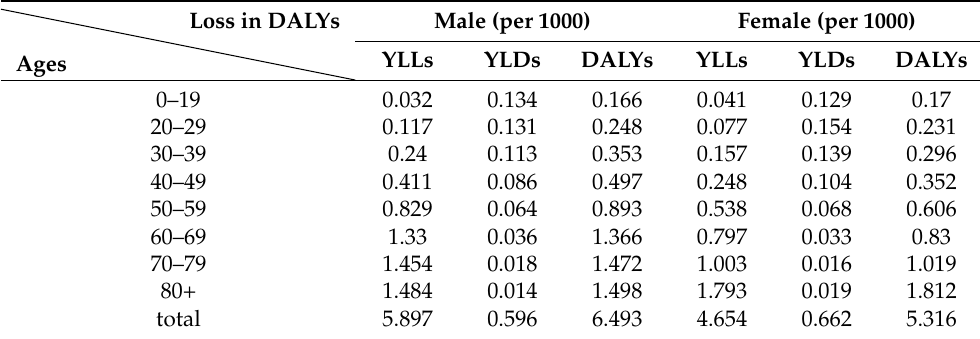
Table 3. The influences of COVID-19 on years of life lost (YLLs), years living with disability (YLDs),